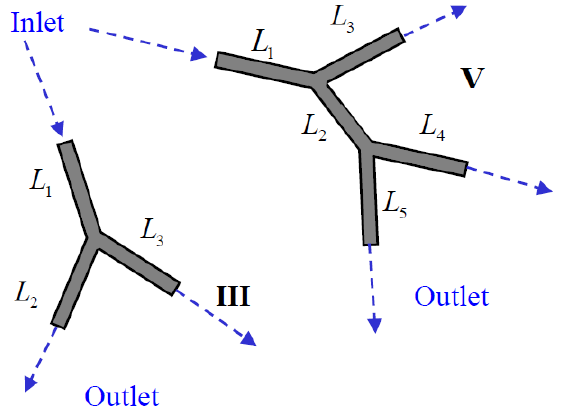
Figure 1. The three-vessels (III) and five-vessels (V) configurations. Table 1. The lengths and the radii of the three and five-vessel configurations. Length Radius Configuration III-a Identical